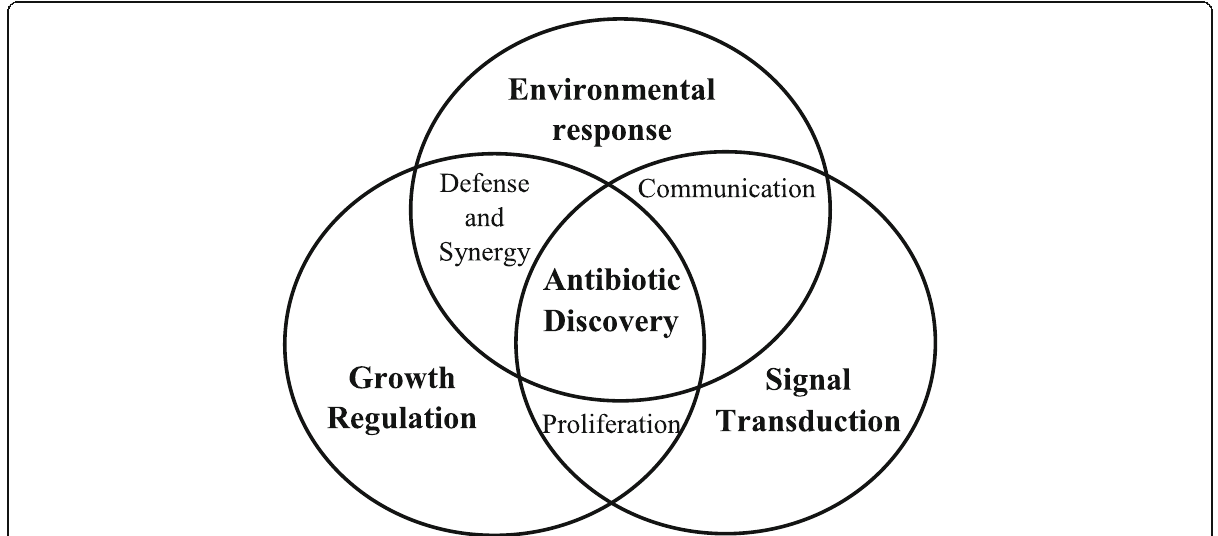
Fig. 10 Strategies need for future antibiotic discovery